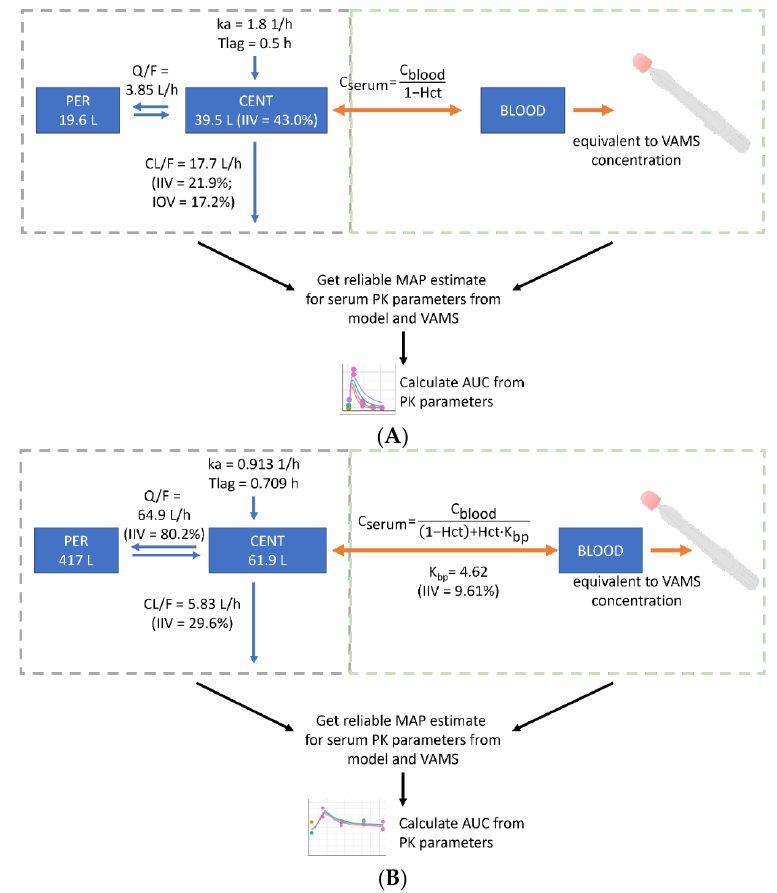
Figure 1. Development of the population pharmacokinetic (popPK) model-informed